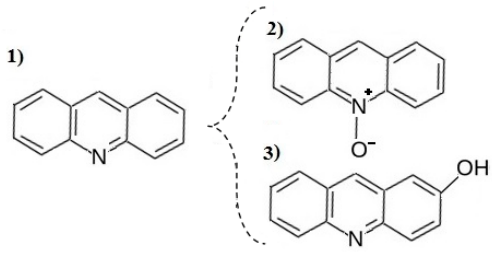
Figure 8. Identified 1 acridine by-products, where 2 is acridine-N-oxide and 3 is 2-hydroxyacridine.